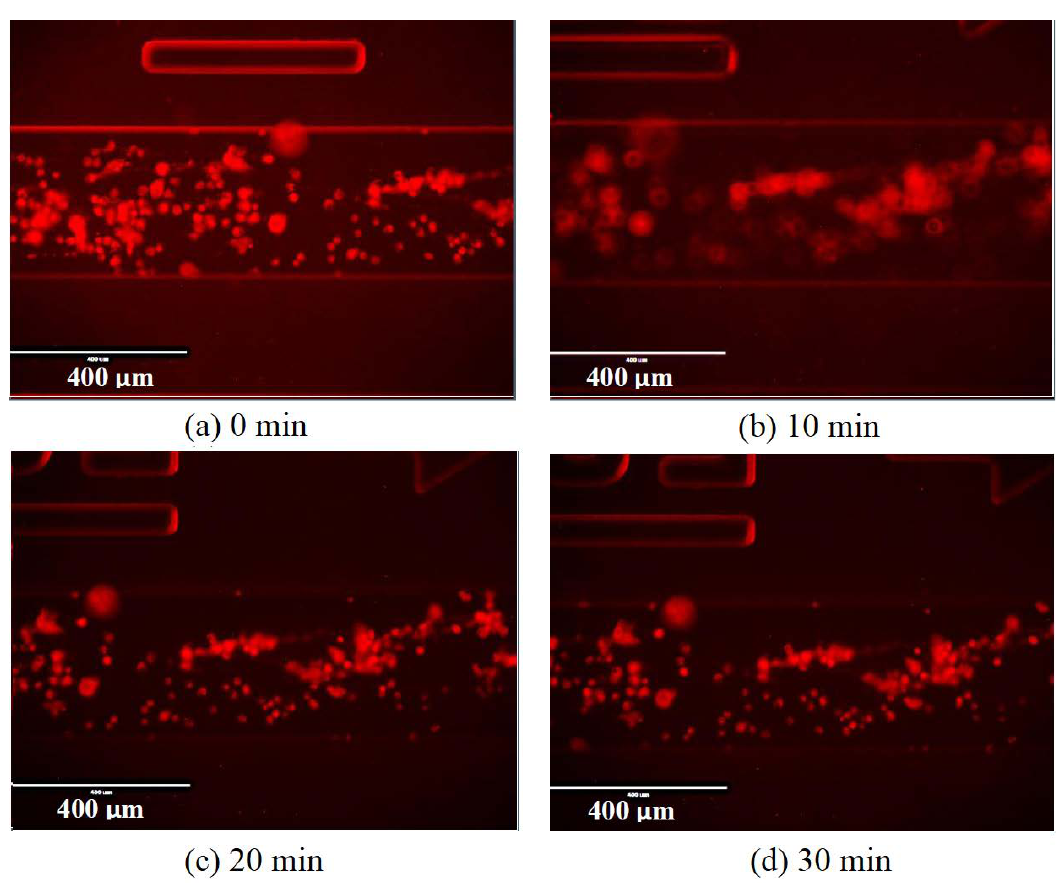
Figure A7. Dark field microscope images for the cells in a hypoxic state exposed to DPBS. ( a ) Image taken at 0 min. ( b ) Image taken at 10 min. ( c ) Image taken at 20 min. ( d ) Image taken at 30